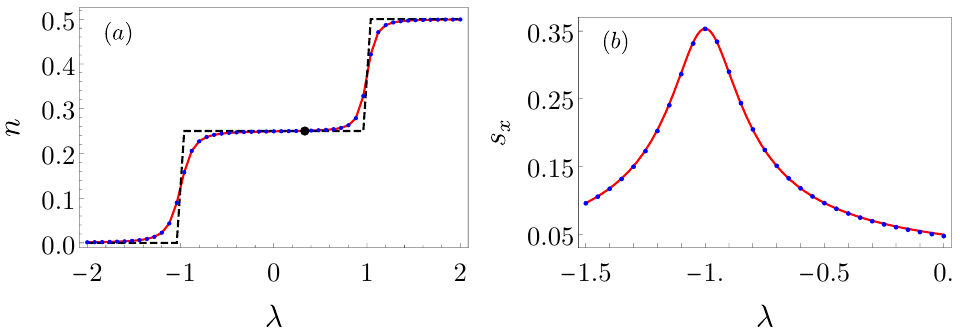
Figure 2: (a): Plot of the Rydberg excitation density n as a function of λ with w = 0 (black dotted line) and w = 0.05 (blue dots) for the two leg-ladder indicating the plateau at with n = 1 / 4 between − 1 ≤ λ ≤ 1 as obtained using ED. The red solid line indicates n as computed using variational wavefunction analysis around λ = ± 1. The black circle at λ ∼ 0.33 shows the position of the Ising transition. (b): Plot of s as a function of λ across the crossover at λ ≃ − 1. The solid red line indicate results from the variational wavefunction approach while the blue dots indicates ED results corresponding to N = 20. All energies are scaled in units of ∆ . See text for